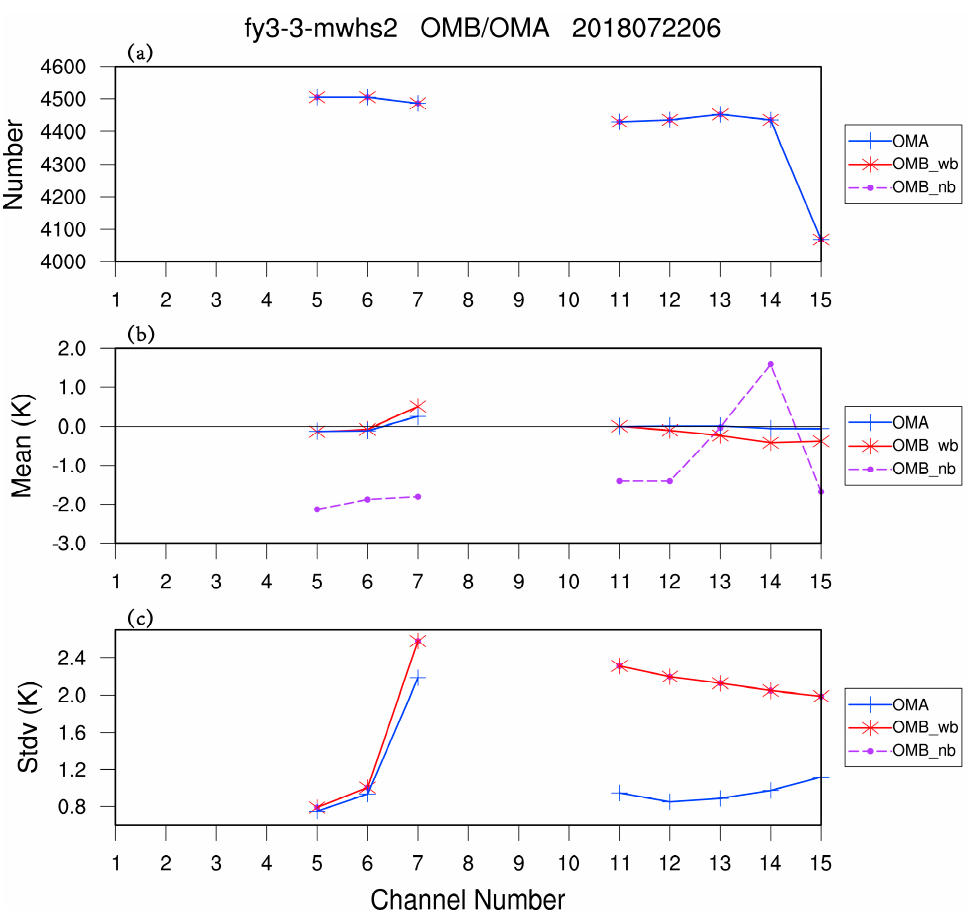
Figure 7. ( a ) The numbers, ( b ) the means, and ( c ) the standard deviations of the used channels.